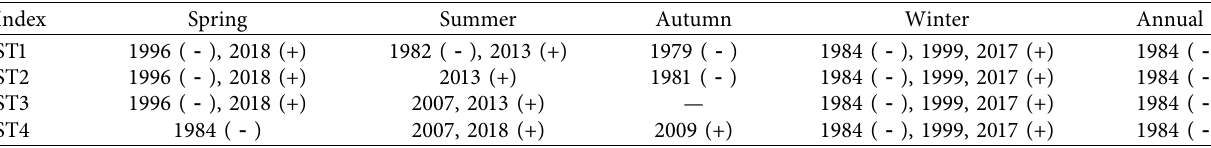
Table 3: Years of anomalous annual and seasonal mean soil temperatures over the Poyang Lake Basin.